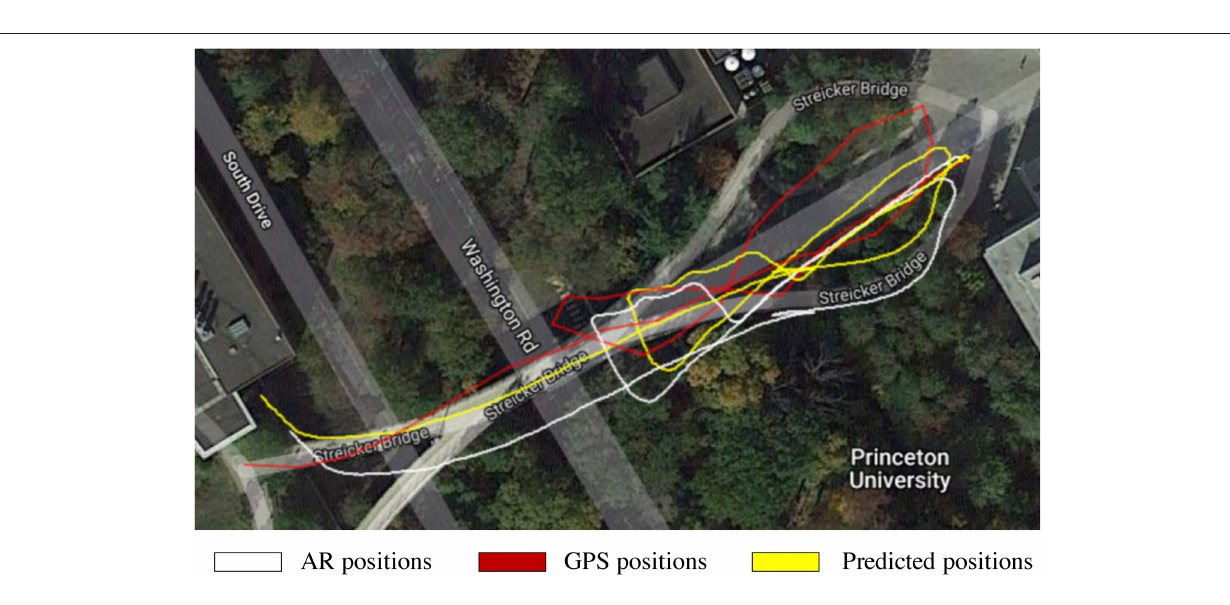
FIGURE 14 | X and y positions of the user during the test according to AR, GPS, and